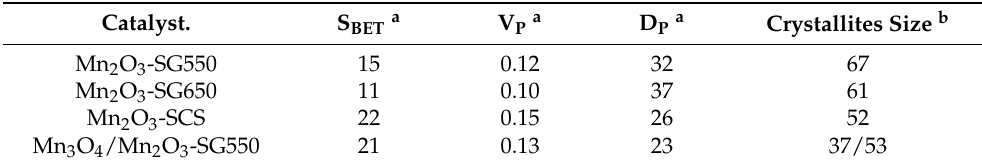
Table 1. Textural properties of the synthesized catalysts, calculated by means of the N 2 physisorption at − 196 ◦ C technique a and the Scherrer formula b . S BET = specific surface area (m 2 g − 1 ); Vp = Total pore volume (cm 3 g − 1 ); D p = average pore diameter (nm); Crystallites size (nm). Catalyst.